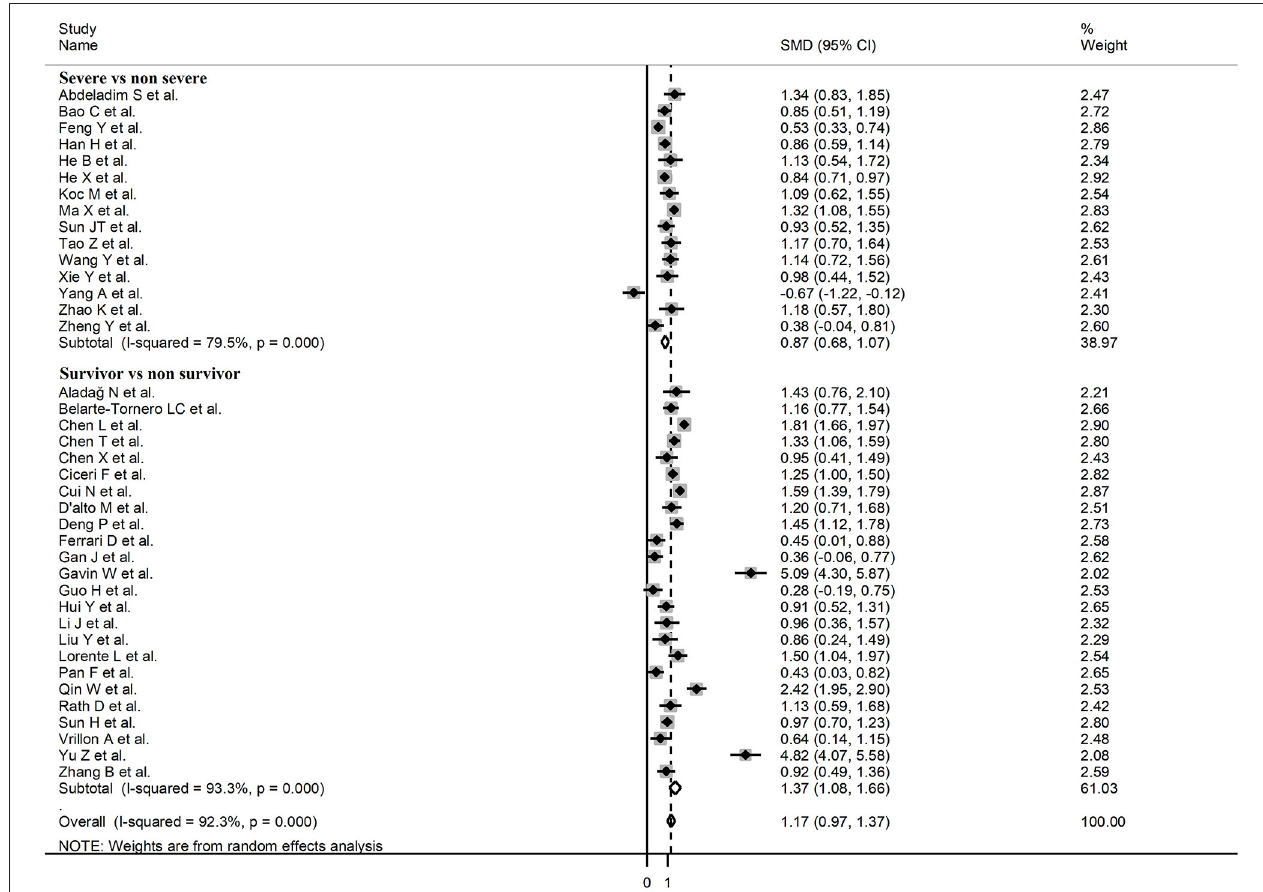
FIGURE 5 | Forest plot of studies reporting BNP concentrations in patients with COVID-19 according to disease severity or survival status.